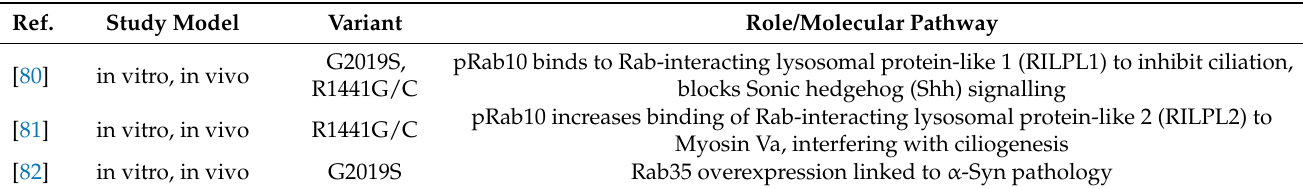
Table 12. LRRK2 and Rab interactions in pathogenic